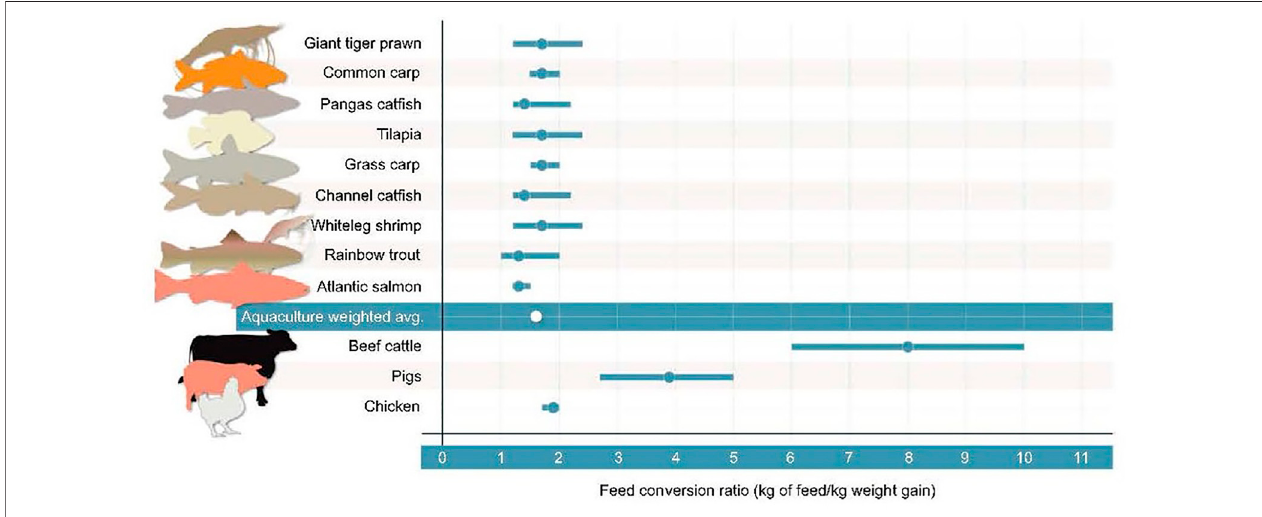
FIGURE 1 | Feed conversion ratios for selected aquaculture species compared to main terrestrial farmed species. Dots represent means and bars indicate the range. Lower values represent higher feed conversion and productivity (from Fry et al., 2018).